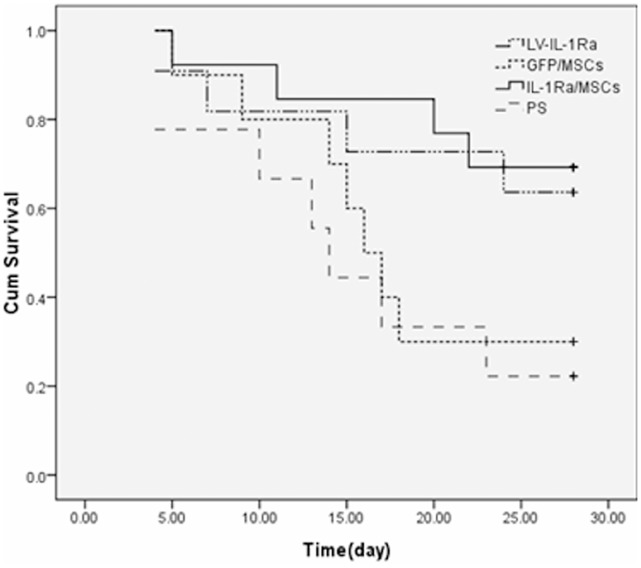
Kaplan-Meier plot showing the pattern of survival of fulminant hepatic failure (n = 15/group) after various treatments.LV-IL-1Ra, Lentiviral-Interleukin-1 receptor antagonist; MSCs, mesenchymal stem cells; PS, physiological saline; GFP, green fluorescence protein.